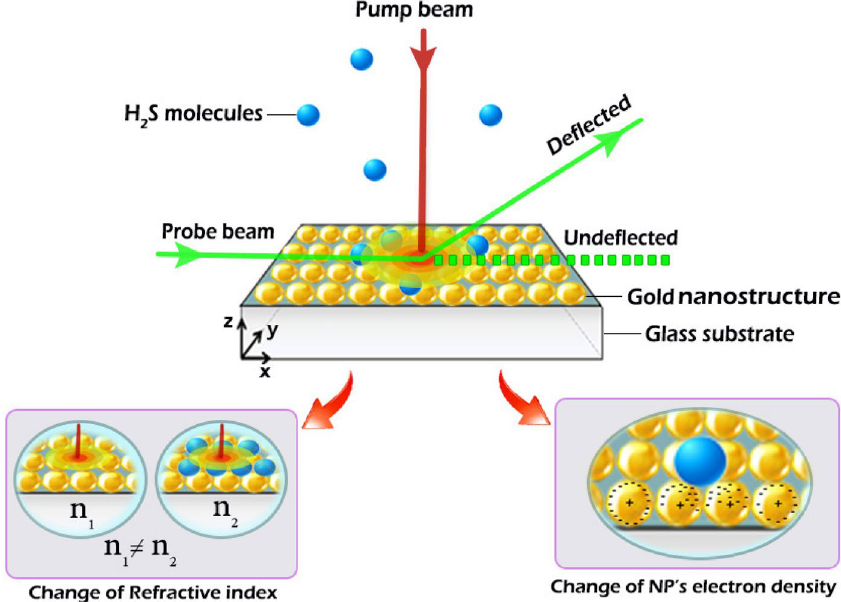
Figure 5. The schematic diagram of the proposed H 2 S detection system based on beam